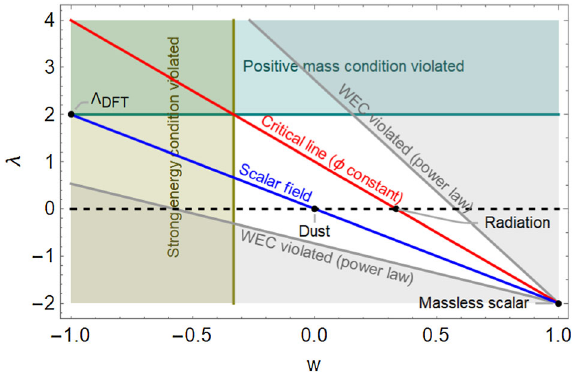
Fig. 1 Energy conditions and types of matter depicted in the (w,λ) - plane. The dotted line corresponds to conventional ‘SUGRA’, in which the matter Lagrangian does not couple to the dilaton and hence T ( 0 ) = 0. All energy conditions are respected in the white region. The strong energy condition (3.19) can in fact be preserved for w < − 1 / 3 in the presence of non-trivial H -flux. We emphasize that the region depicted asviolatingtheweakenergy condition (3.21) isspecificallyrestrictedto thecaseofthepower-lawansatzdiscussedinSect.4.Theright-handpart of the strong (3.19) and weak energy conditions (3.21) is automatically satisfied in the depicted region, for which w ≥ −